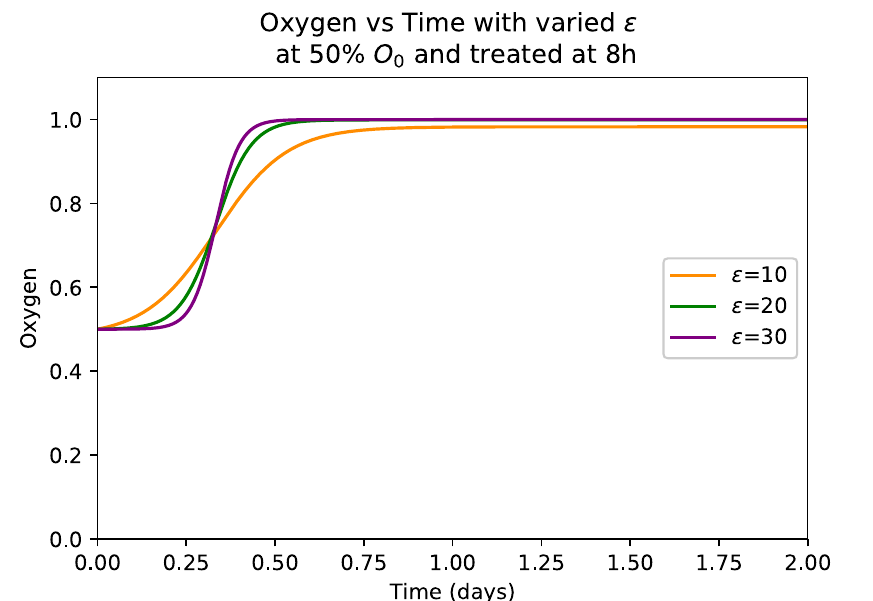
Fig 3. Demonstration of the oxygen function at 50% initial O 0 values for different values of �